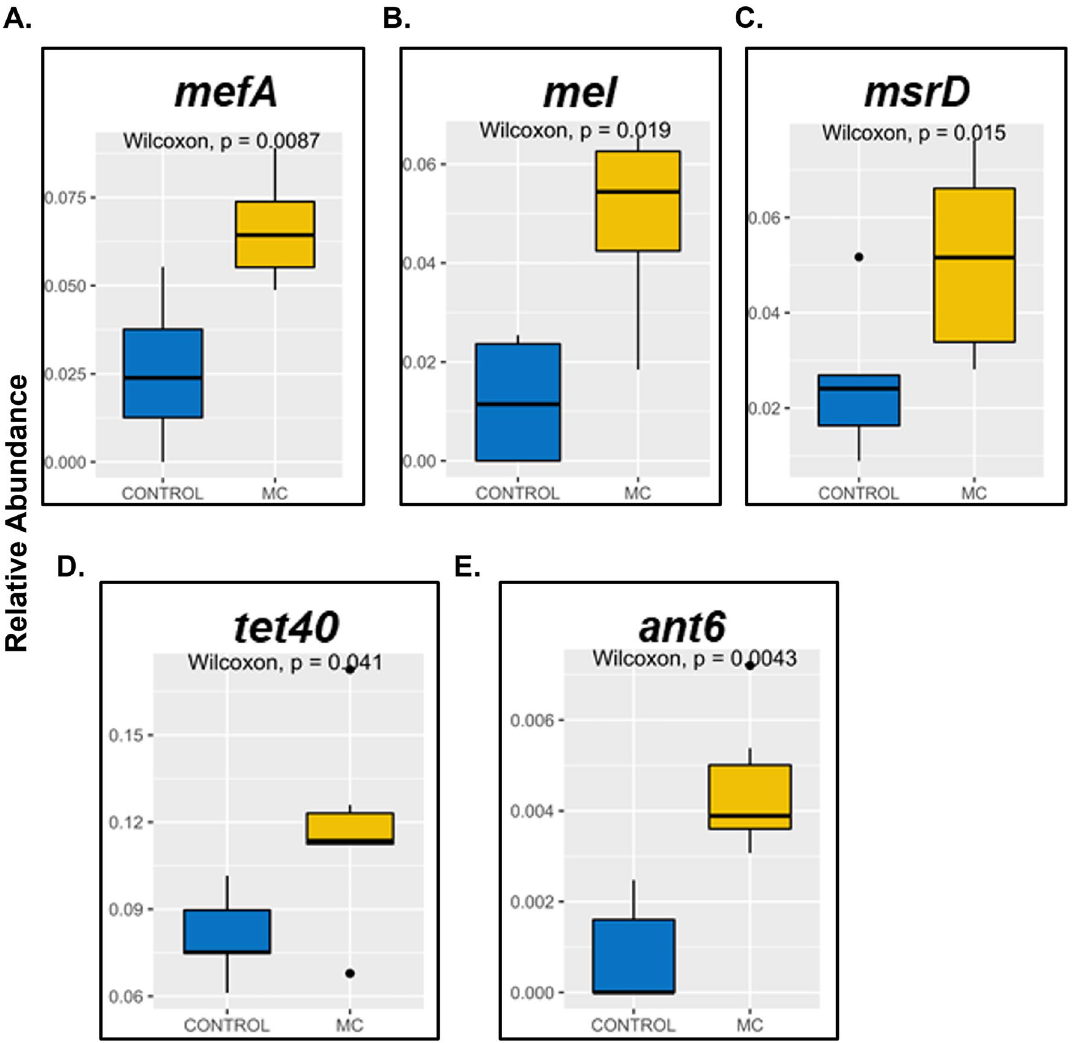
Figure 4. Box and whisker plots for differentially abundant resistance genes including macrolide-resistant class [( A ) mefA , ( B ) mel , and ( C ) msrD ], tetracycline-resistant class [( D ) tet40 ], and aminoglycoside-resistant class [( E ) ant6